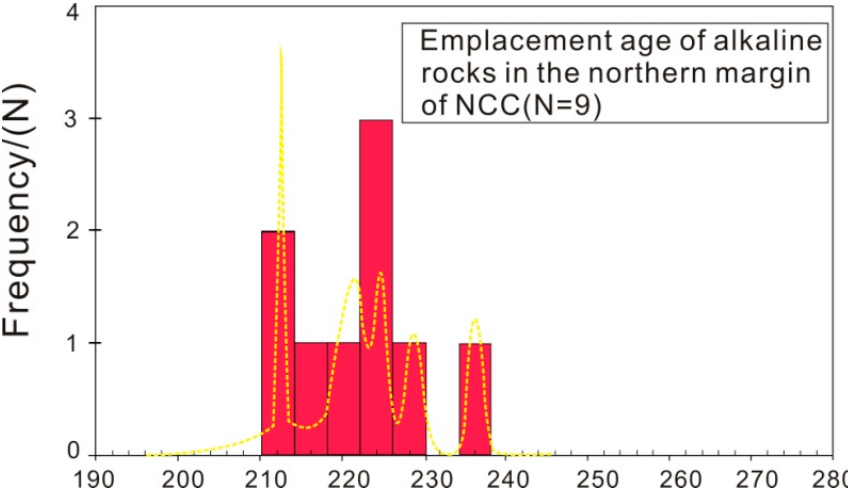
Figure 11. Histogram of alkaline rock emplacement ages in the northern margin of NCC. Data sources: The alkaline rocks are from [8,13,45] and this study.